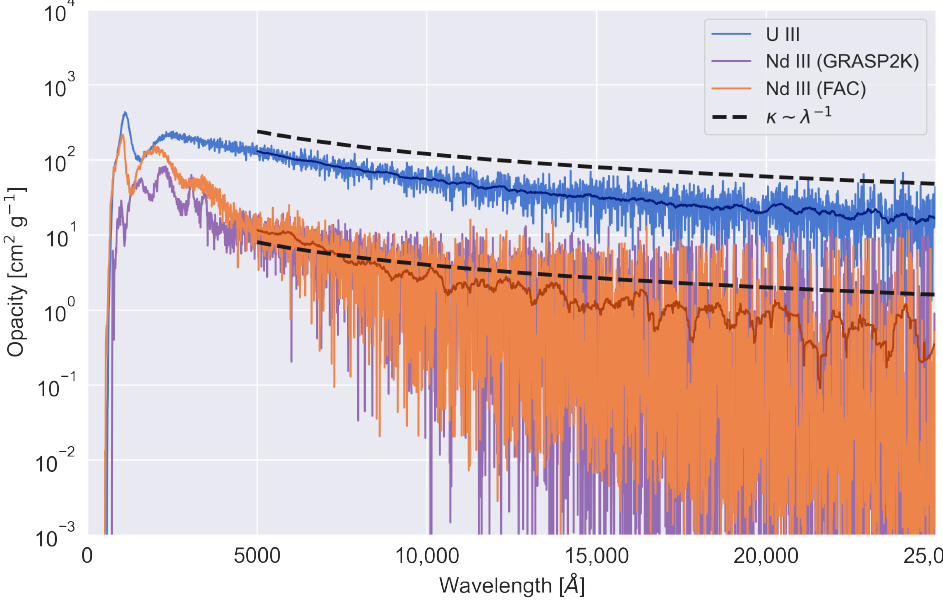
Figure 4. Expansion opacity for U III and Nd III (Calculation B) from the calculations performed with FAC. The expansion opacity of Nd III calculated using the data from Gaigalas et al. [22] is also to provide a more visual comparison between the two results. The opacity was evaluated at t = 1 day for the typical density and temperature values of ρ = 10 − 13 gcm − 3 and T = 10,000K assumed by other calculations. A wavelength bin of ∆ λ = 10 Å was used. An average over a set of 10 bins is also shown in darker blue and orange lines. The black dashed line highlights the wavelength dependence of the opacity following approximately a λ − 1 power